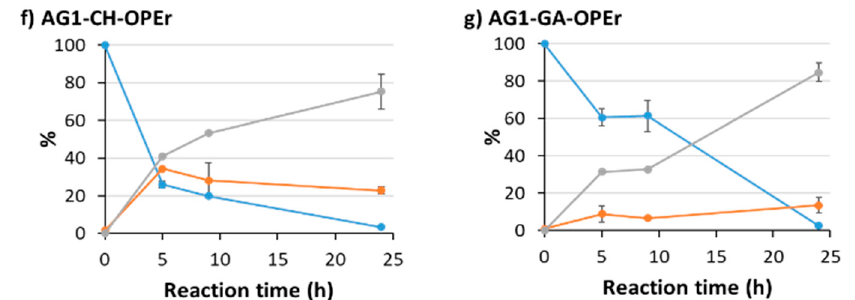
Figure 3. Time course of the enzymatic transesterification of recycled cooking oil and methanol catalyzed by OPEr and its immobilized biocatalysts, showing the percentage of triglycerides, FAMEs, and other reaction products. ( a ) Soluble OPEr; ( b ) AMNP-CH-OPEr; ( c ) AMNP-GA-OPEr; ( d ) mCLEAs-OPEr; ( e ) SiMAG-octyl-OPEr; ( f ) AG1-CH-OPEr; ( g ) AG1-GA-OPEr. The reactions were developed over 24 h at 25 °C, with a rotational stirring (100 rpm), an oil:methanol ratio of 1:4 and 100 mg of each nanobiocatalyst. TGs: Triglycerides; DGs: Diglycerides; MGs: Monoglycerides; FFAs: Fatty acids; FAMEs: Methyl esters.